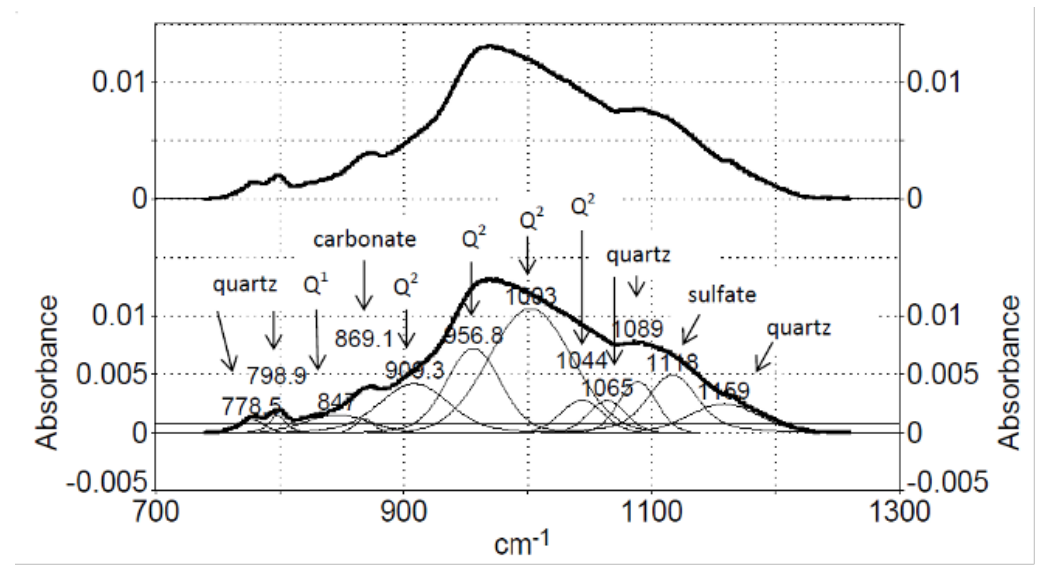
stored in closed containers at 23